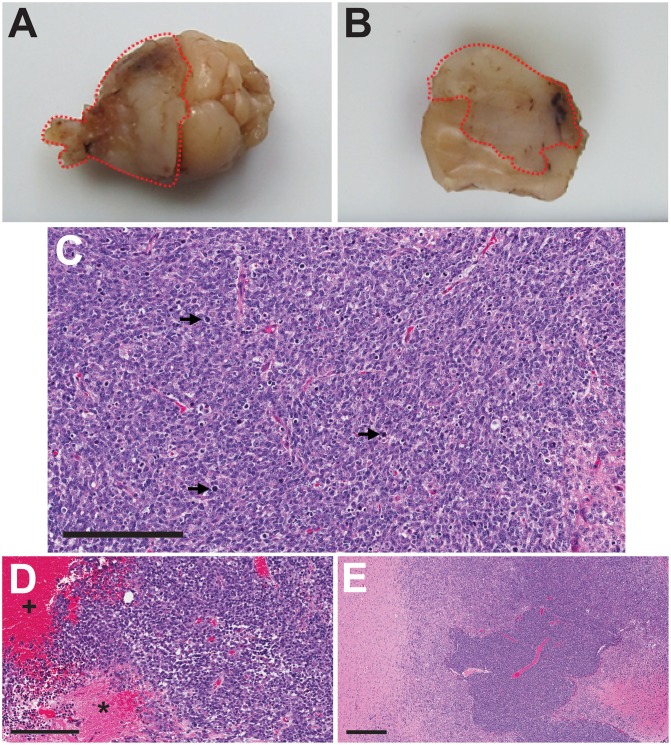
Gross and microscopic pathology of the IC3752 pediatric glioma tumor.(A-B) Formalin fixed IC3752 pGBM tissue, characterized as a yellowish gray and poorly demarcated mass, with multifocal areas of necrosis and hemorrhage. (C-E) Histological examination revealed poorly demarcated, unencapsulated, and invasive neoplasms (E) characterized by marked cell atypia, a high mitotic index (black arrows) (C), and multifocal areas of necrosis (asterisks) and hemorrhage (plus sign) (D). T = Tumor, B = normal brain. Scale bar = 200 μm (C-D). Scale bar = 400 μm (E).